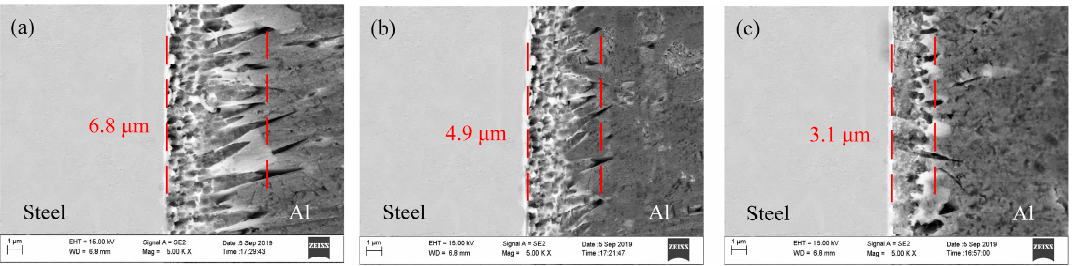
Figure 13. Phase composition of the IMCs layer under different welding parameters: ( a ) wire feeding speed; ( b ) Laser power; ( c ) Welding speed.